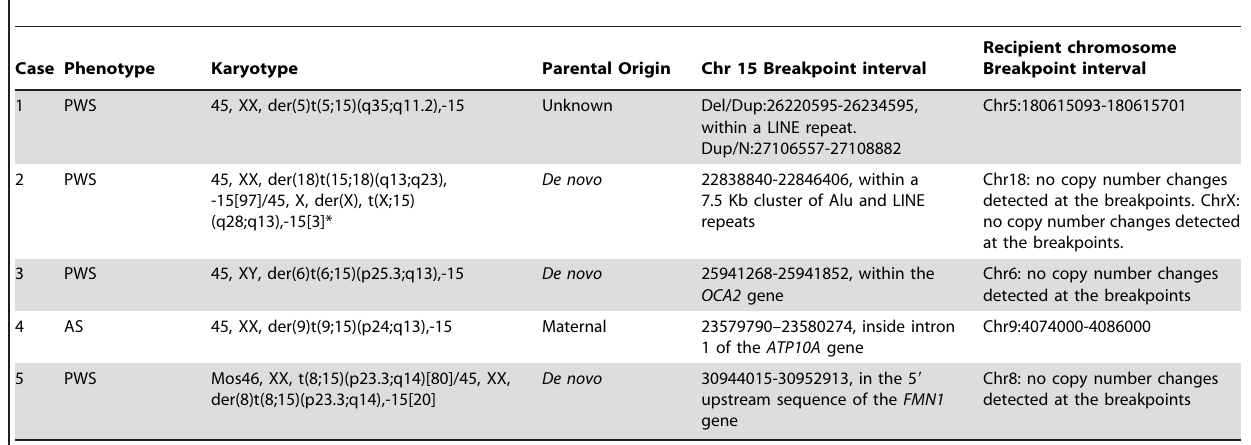
Table 1. Phenotype, karyotype and molecular characterization of the five cases with unbalanced